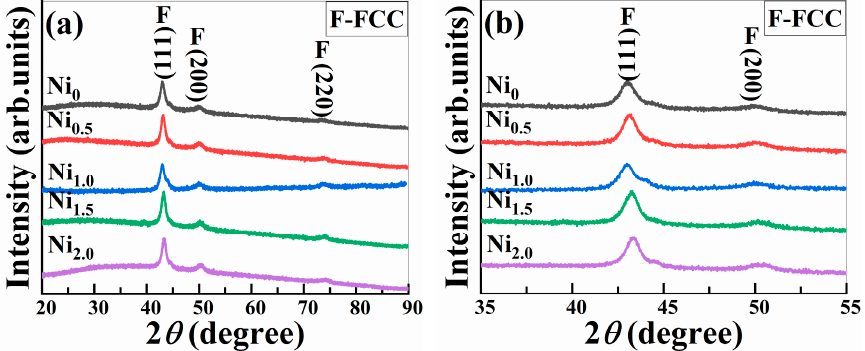
Figure 3. ( a ) XRD pattern of CoCrCuFeMnNi x HEAPs after 50 h ball milling; ( b ) enlarged view of 35–55°.